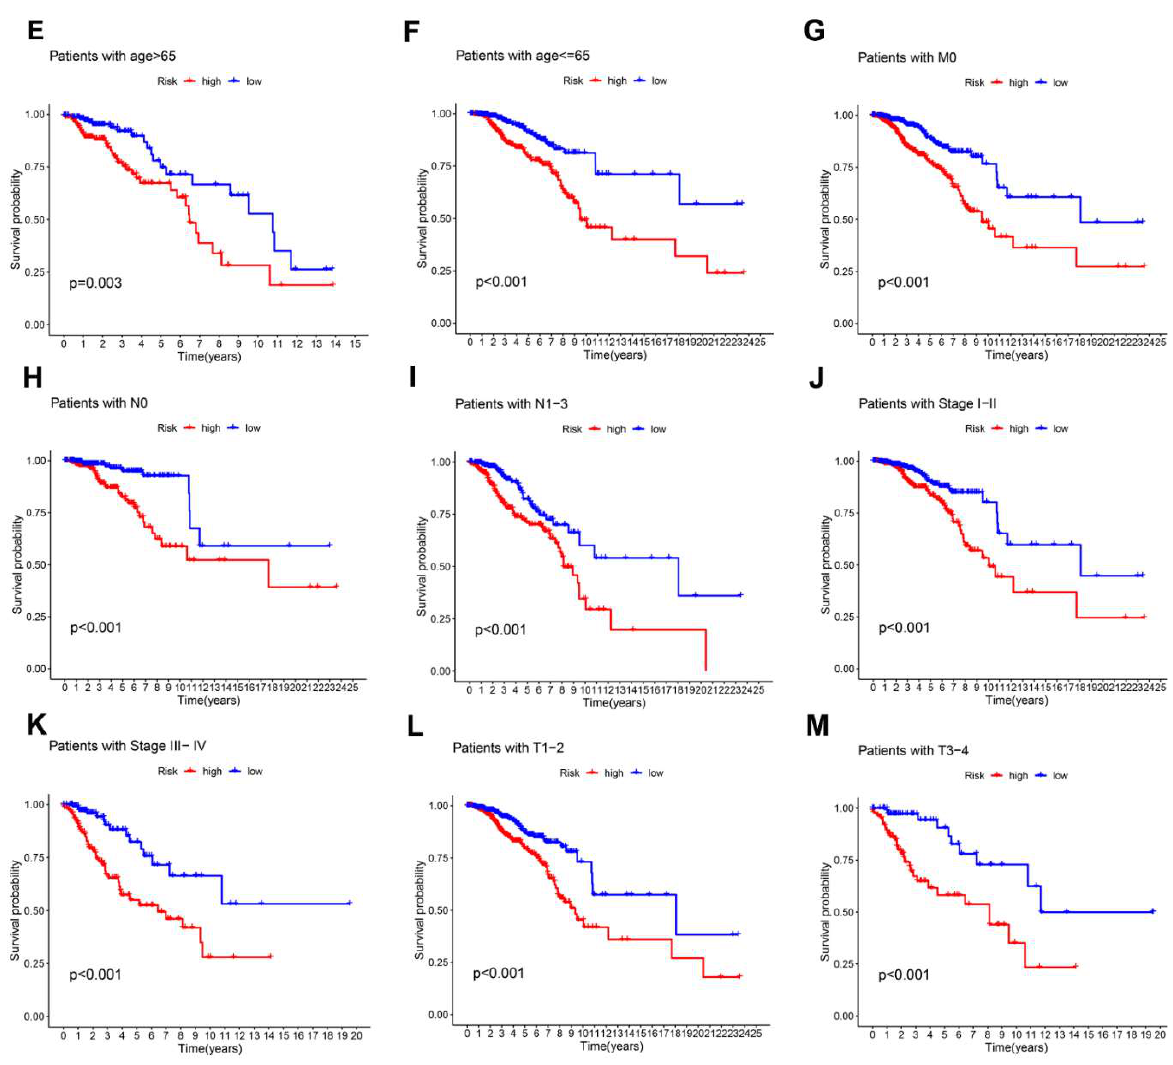
Figure 6. Evaluation of AR-LncM features. Univariate and multivariate Cox forest plots for risk scores and clinical characteristics in the training set ( A , C ) and the validation set ( B , D ). ( E – M ) Survival analysis of high- and low-risk groups adjusted for the clinical characteristics, such as age, metastatic status, lymph node status, tumor stage, and tumor size, of BC patients.